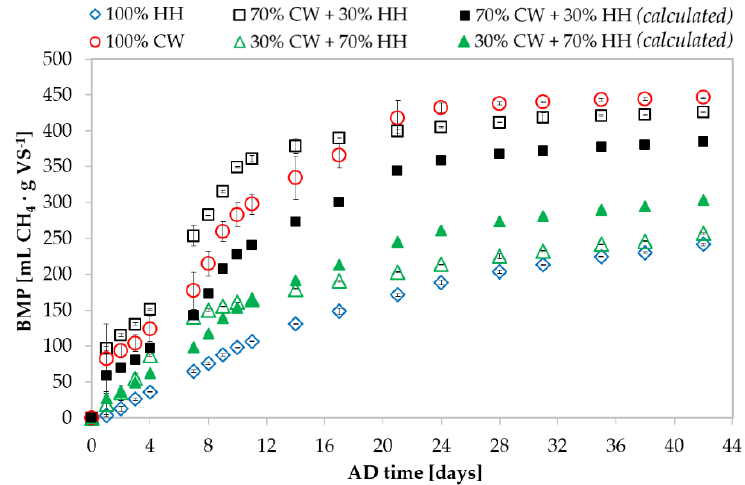
Figure 1. Cumulative, specific biomethane production profiles obtained along the 42 days of mesophilic anaerobic digestion and co ‐ digestion with the four different substrate combinations tested. The filled squares and triangles indicate the calculated biomethane productions.